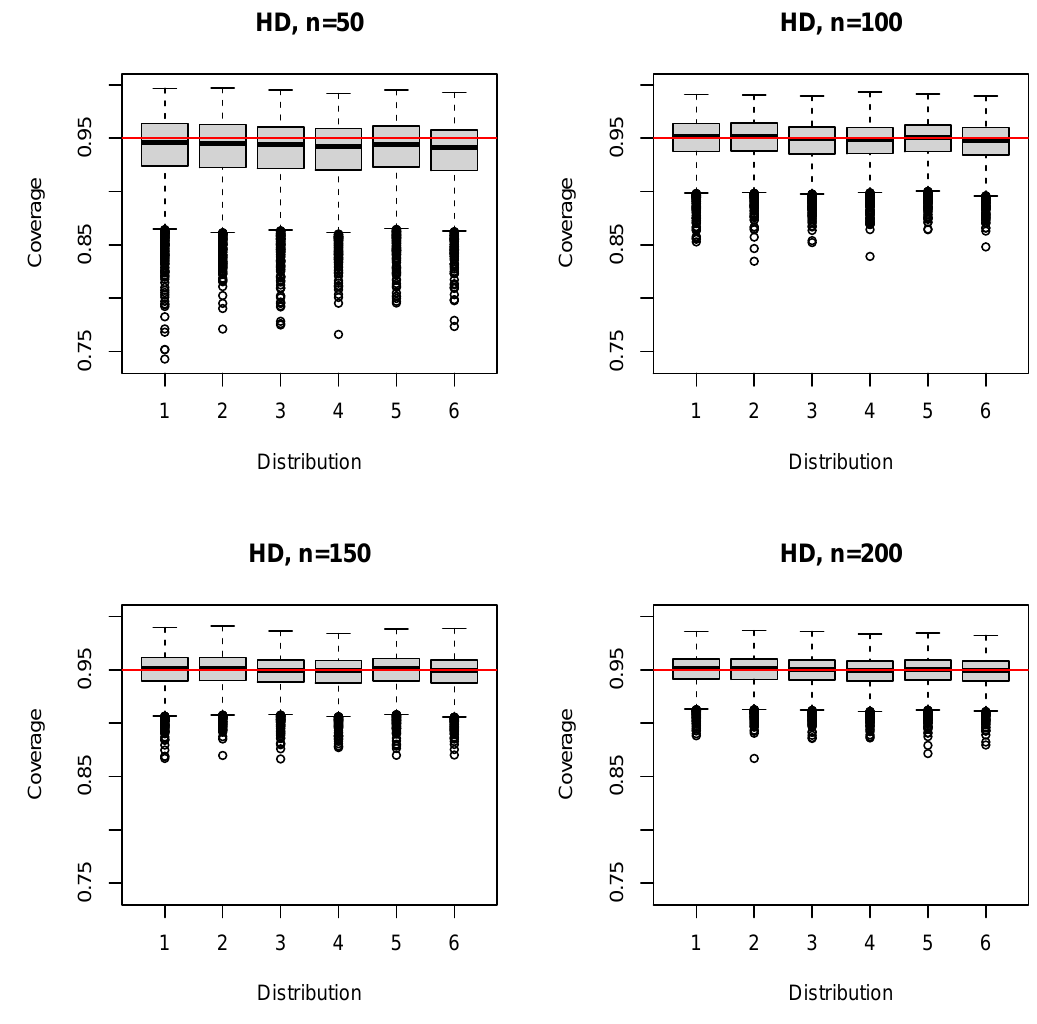
Figure 5. Boxplots of the coverage probability for the HD estimator and n = 50 ( 50 )